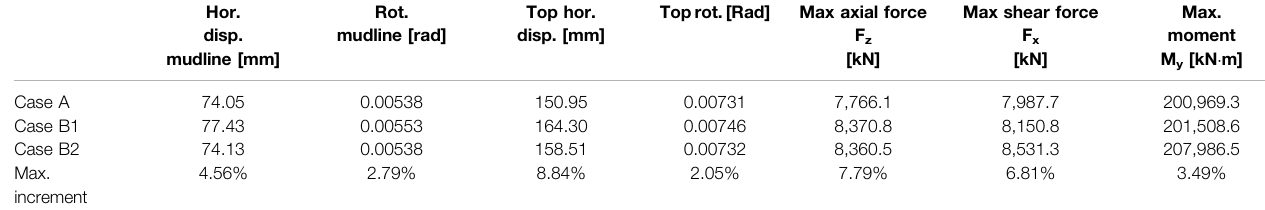
TABLE 6 | Displacement and internal force in the ultimate limit state (ULS). Hor. disp.